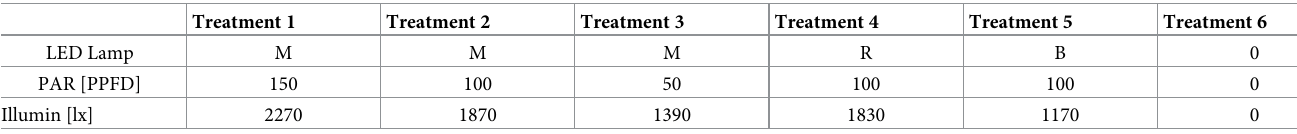
Table 1. LED light characterization for each treatment. Treatment